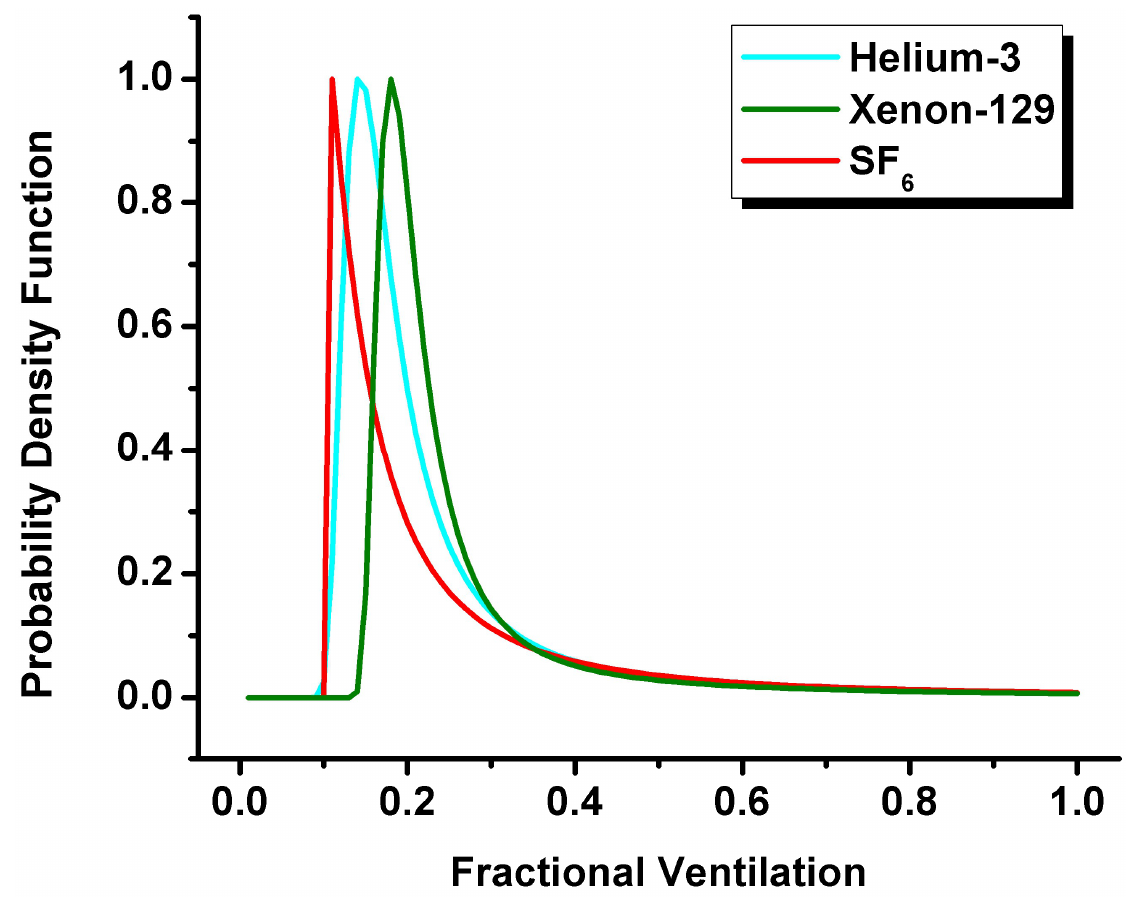
Figure 3. Normalized regional fractional-ventilation distributions obtained for representative animals ventilated with three different gases. Bulk fractional-ventilation distributions obtained for 3 He (mean r (cid:48) = 0.22, mean β = 0.98, r SEM = 0.26, cyan line), 129 Xe (mean r (cid:48) = 0.24, mean β = 0.90, r SEM = 0.28, dark green line), and 19 F (mean r (cid:48) = 0.14, mean β = 0.76, r SEM = 0.24, red line) gases from three different animals. The plot shows the smallest r SEM peak value for 19 F contract agent and largest r SEM peak value for 129 Xe contract agent (0.11 vs. 0.18 for peak values, respectively). r (cid:48) = apparent MRI fractional-ventilation estimate; β = MRI-derived heterogeneity index; r SEM = MRI-derived SEM-based regional fractional-ventilation; SEM = stretched exponential model. The noticeable difference between β generated from the 3 He/ 129 Xe MRI and 19 F MRI measurements is likely due to the use of two different ventilators and different ventilator settings are dictated by the physical property of the three gases.